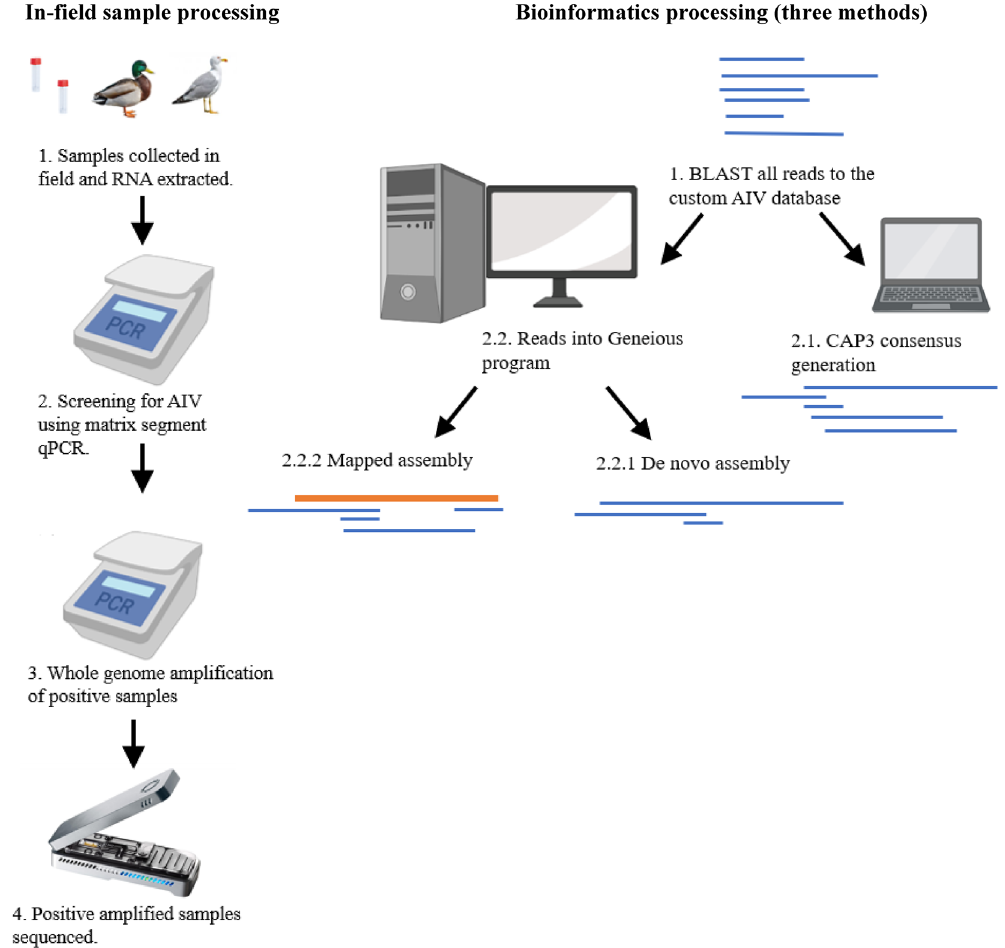
Figure 1. Flow chart of methods used in the study from sample collection to bioinformatic